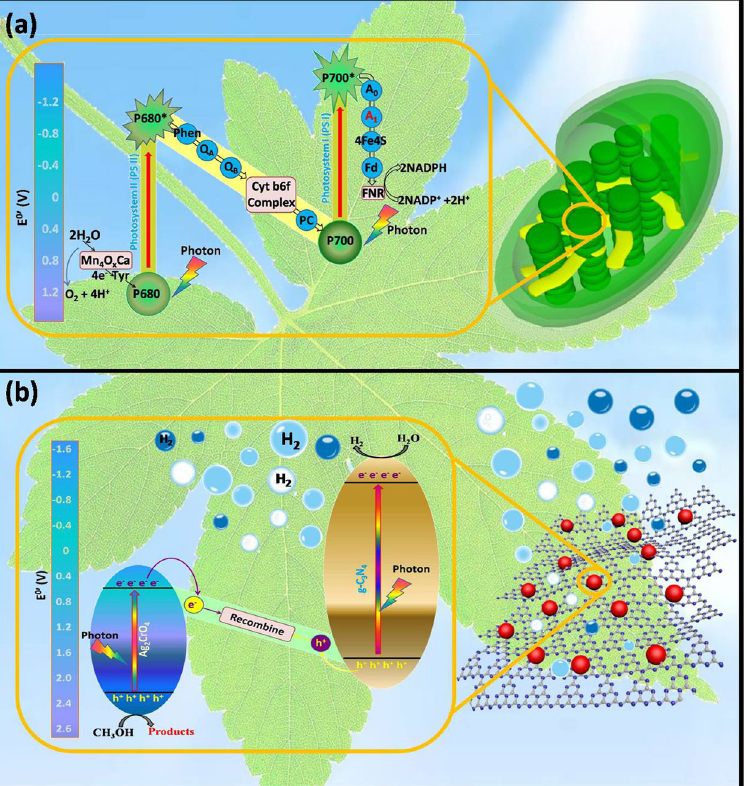
Figure 1. ( a ) Natural photosynthesis (the electrons in HOMO of PS II are excited to its LUMO under solar light; Then, the photogenerated electrons in LUMO of PS II are transferred to HOMO of PS I through the electron mediator. Further, the electrons in HOMO of PS I are excited to its LUMO. The transfer process of electrons in the figure constitutes a shape of letter Z, so it is called a Z-scheme) and ( b ) an artificial analogy composed of an organic semiconductor g-C 3 N 4 (equivalent to PS I) and silver chromate (equivalent to PS II) (the electrons in HOMO of Ag 2 CrO 4 are excited to its LUMO under visible light irradiation; Then, the electrons in HOMO of g-C 3 N 4 are excited to its LUMO under visible light irradiation; the excited electrons of Ag 2 CrO 4 and the holes of g-C 3 N 4 recombine; as a result, the migration route of electrons is a